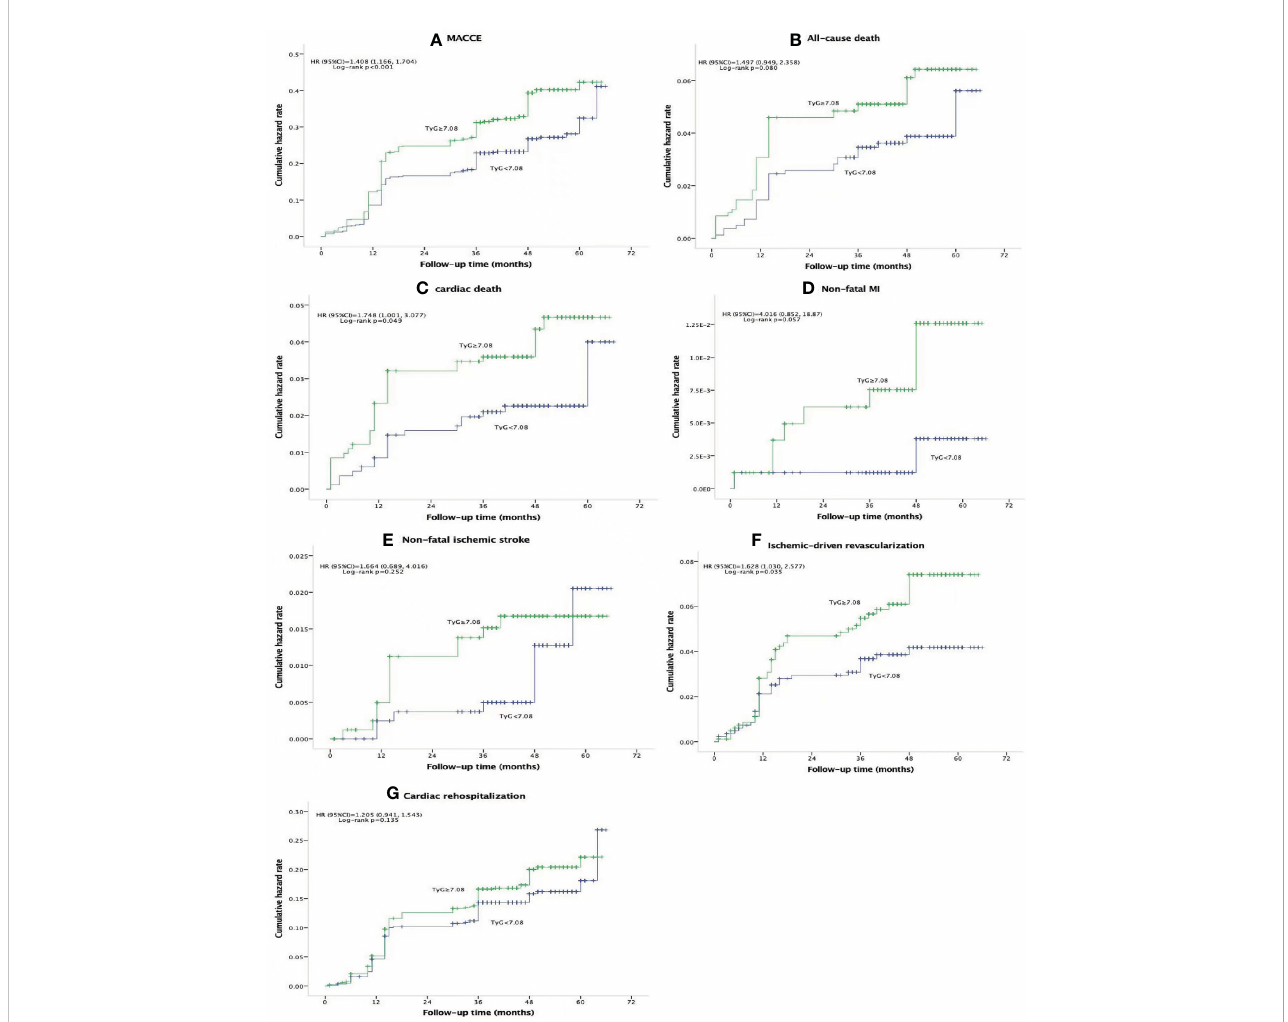
FIGURE 2 Kaplan-Meier curves for composite MACCE (A) , all-cause death (B) , cardiac death (C) , non-fatal MI (D) , non-fatal ischemic stroke (E) , schemic-driven revascularization (F) , and cardiac rehospitalization (G) of the TyG<7.08 group (blue line) versus the TyG<7.08 group (green line). TYG, triglyceride-glucose index; MACCE, major adverse cardiovascular and cerebrovascular event; MI, myocardial infarction; HR, hazard ratio; Cl, con fi dence